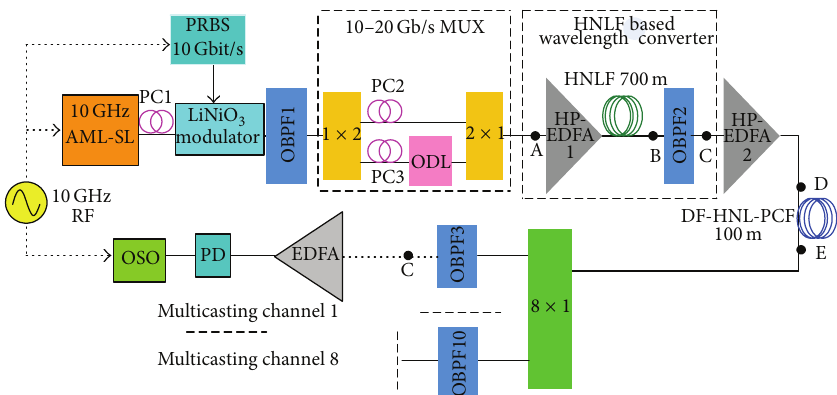
Figure 5: Experimental setup of DF-HNL-PCF based all-optical wavelength multicasting scheme.